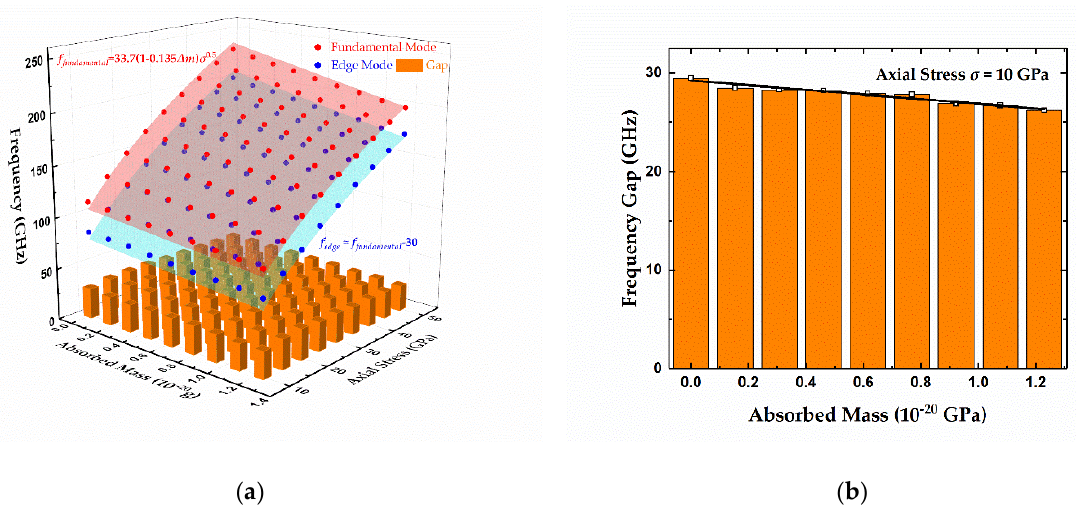
Figure 6. ( a ) Resonant frequencies of fundamental modes and edge modes versus evenly distributed absorbed mass and axial stress. Length and width of the considered doubly clamped graphene sheet are 100 and 50 Å, respectively. ( b ) Resonant frequency gap between fundamental modes and edge modes versus the absorbed mass with axial stress of 10 GPa.